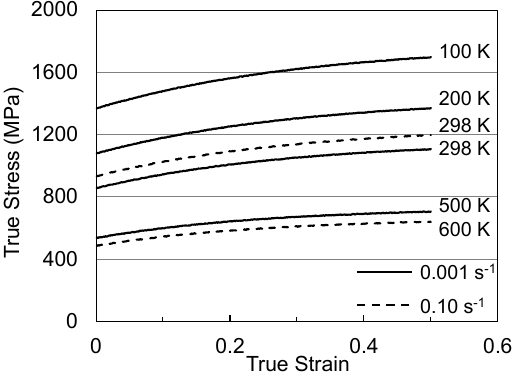
Figure 5. Stress–strain curves at various temperatures and strain rates in Follyalloy in the “Material Supplied” condition.